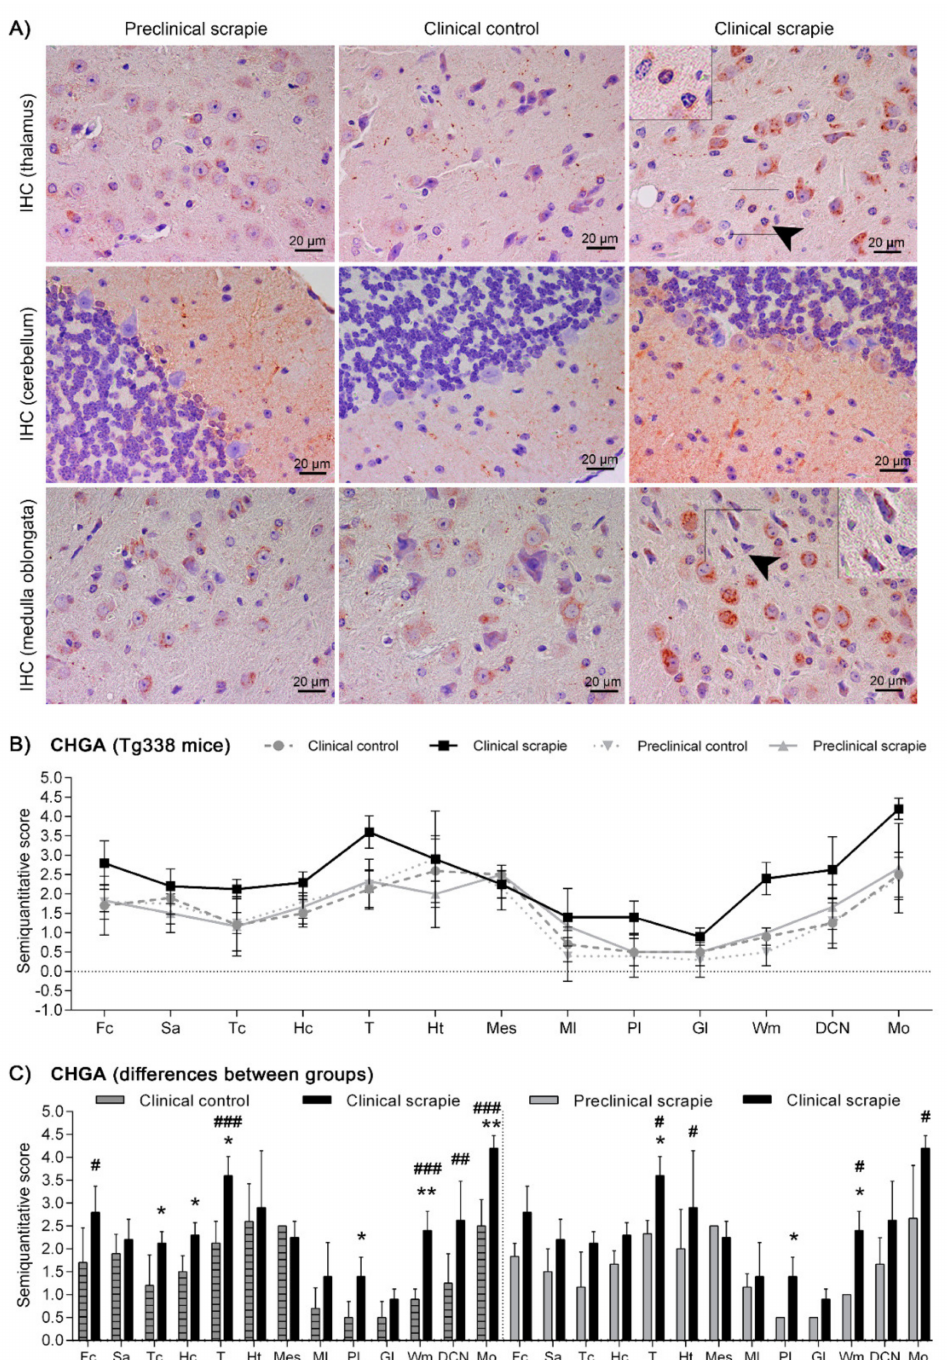
Figure 6. Immunostaining patterns and semi-quantitative scoring of CHGA in the central nervous system of scrapie-infected Tg338 mice. ( A ) Representative images of CHGA immunostaining in the thalamus, cerebellum and medulla oblongata (20 µ m). This protein displayed a linear punctiform synaptic-like immunostaining in the neuropil throughout the brain. In addition, multiple cells exhibited intracytoplasmic granular immunolabelling, being particularly well-defined and strong in the